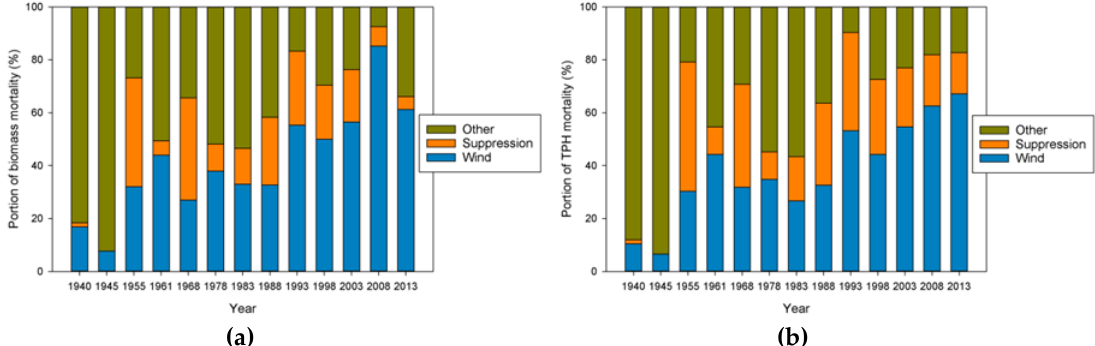
Figure 9. Tree mortality in terms of biomass ( a ) and trees per ha ( b ) resulting from wind, suppression and other or unknown causes across ten permanent plots over